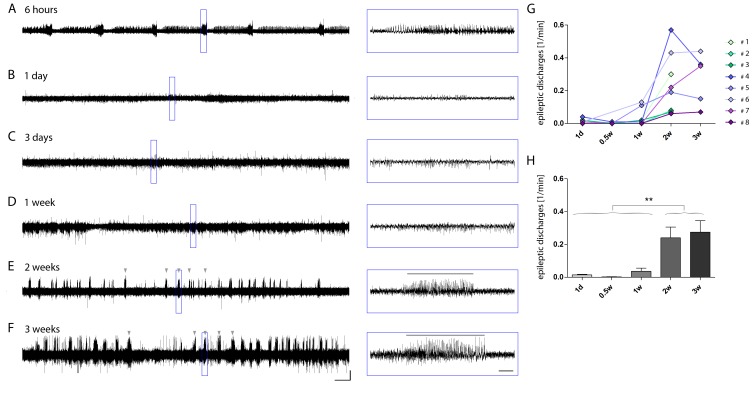
Longitudinal development of epileptiform activity after kainate injection.(A–F) Representative longitudinal EEG recording of the ipsilateral hippocampus of a kainate-injected mouse. Recordings in the same mouse were repeated at different time points during epileptogenesis (6 hr, 1 day, 3 days, 1 week, 2 weeks and 3 weeks following injection). Detailed images of the respective EEG traces are indicated by blue boxes. Scale bars: Horizontal (left) 200 s and (right) 5 s, vertical 1 mV. Grey arrow heads above the trace and horizontal lines in blue boxes denote examples for high-amplitude recurrent paroxysmal episodes, i.e. epileptic discharges. (G) Quantitative analysis for individual mice (color-coded) and H) for groups. One-way ANOVA, Bonferroni’s post-test, **p<0.01, n1d = 8, n0.5w = 6, n1w = 8, n2w = 8, n3w = 5. Values are presented as the mean ± SEM. Individual recordings were binned for time points: 1 day (recordings on day 1), 0.5 week (rec. on days 3–5), 1 week (rec. on days 6–7), 2 weeks (rec. on days 12–16) and 3 weeks (rec. on days 17–21) after SE.